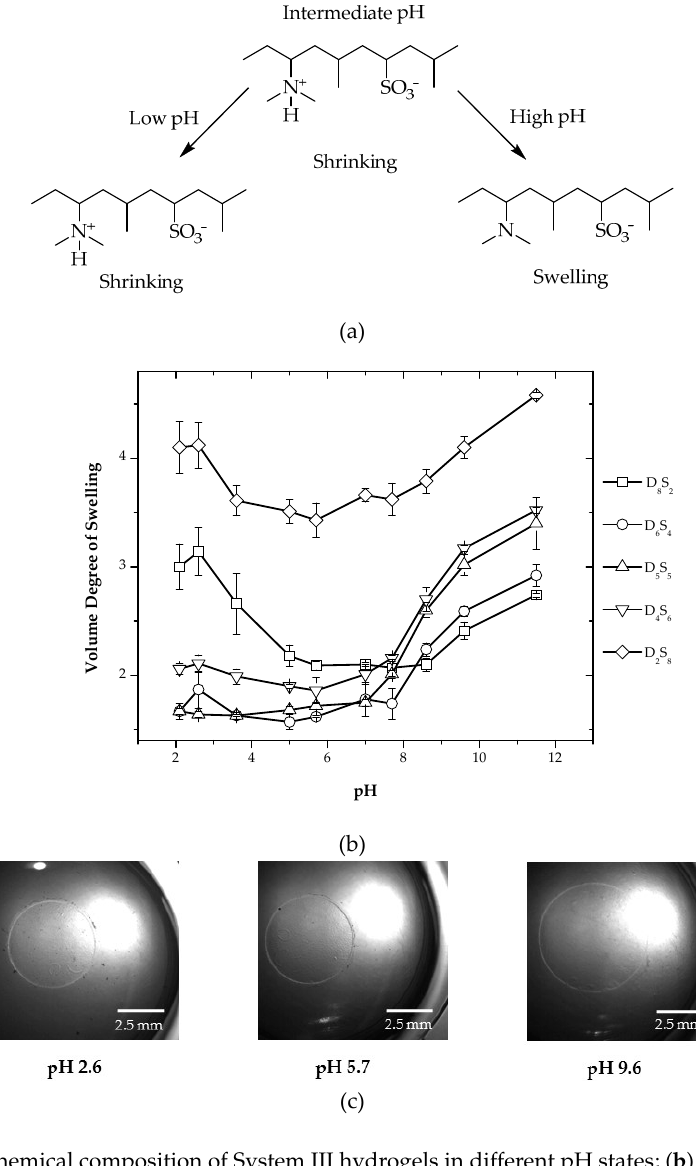
Figure 3. ( a ) Chemical composition of System III hydrogels in different pH states; ( b ) variation of the volume degree of swelling for different compositions of hydrogels; ( c ) optical micrograph showing the change in the diameter of D 5 S 5 hydrogels at pH 2.6, 5.7 and 9.6